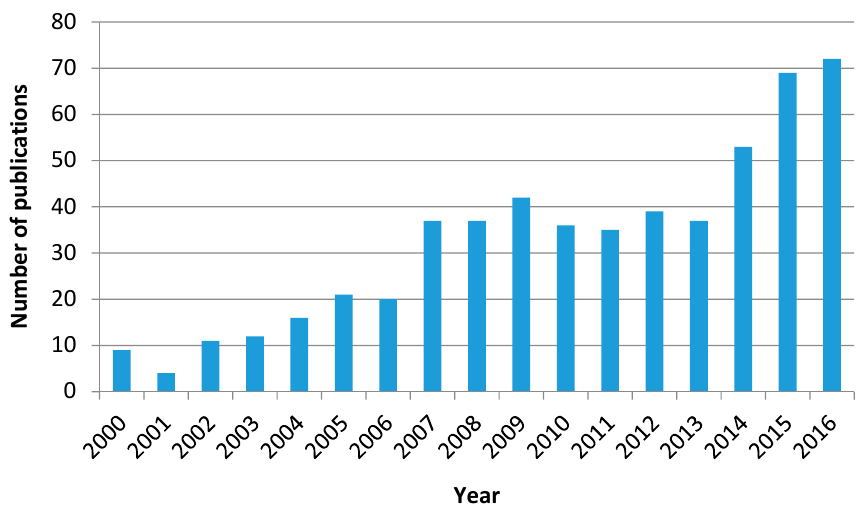
Figure 3. Evolution of the number of publications on water photocatalytic ozonation in the period 2000–2016.